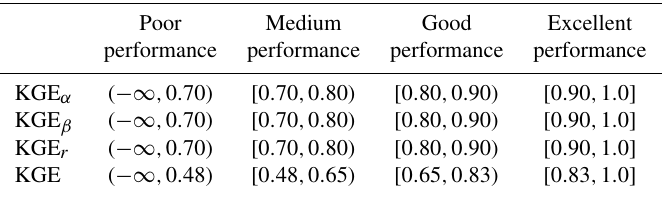
Table 2. Performance levels. The table shows the ranges per metric to qualify as excellent, good, medium, or poor performance. The KGE component thresholds (Eqs. 2–4) are defined independently, while the overall KGE is the result of the thresholds combined through Eq.